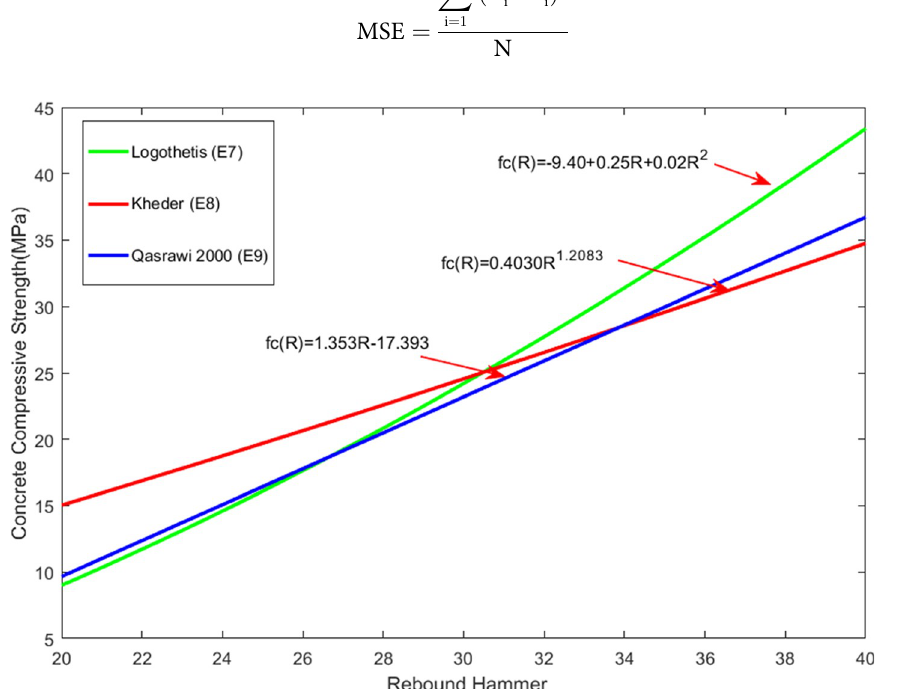
Fig 10. Calculation equations of rebound value and compressive